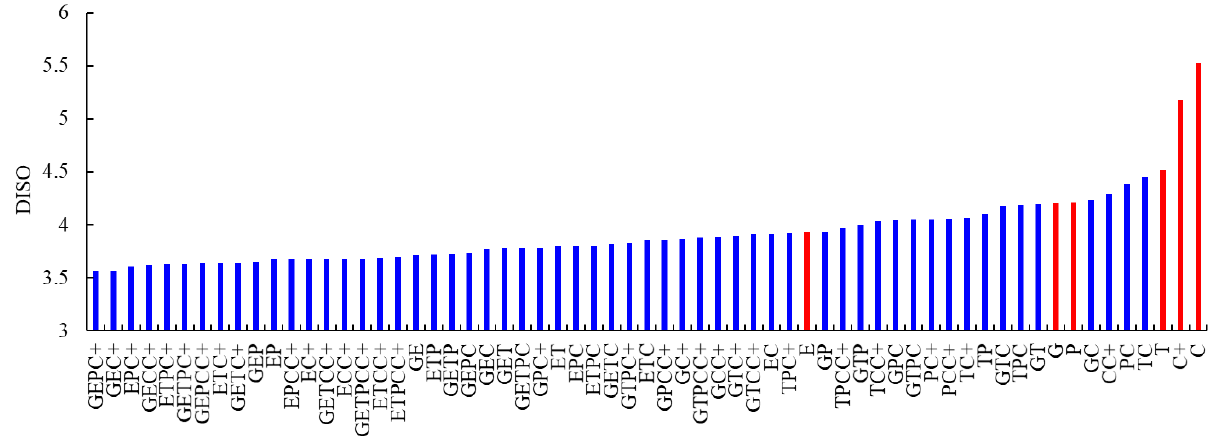
Figure 5. Difference between the observations and simulations of IPPs under the different com- binations across the YRB. DISO is the average value of all calibration stations, and GPM, ERA, TRMM, PERSIANN-CDR, CHIRPS, and CPC are abbreviated as G, E, T, P, C, and C+. For example, GEPC+ is the integrated result of GPM, ERA, PERSIANN-CDR, and CPC. Among them, the red column represents the single precipitation products, and the blue column represent the integrated precipitation